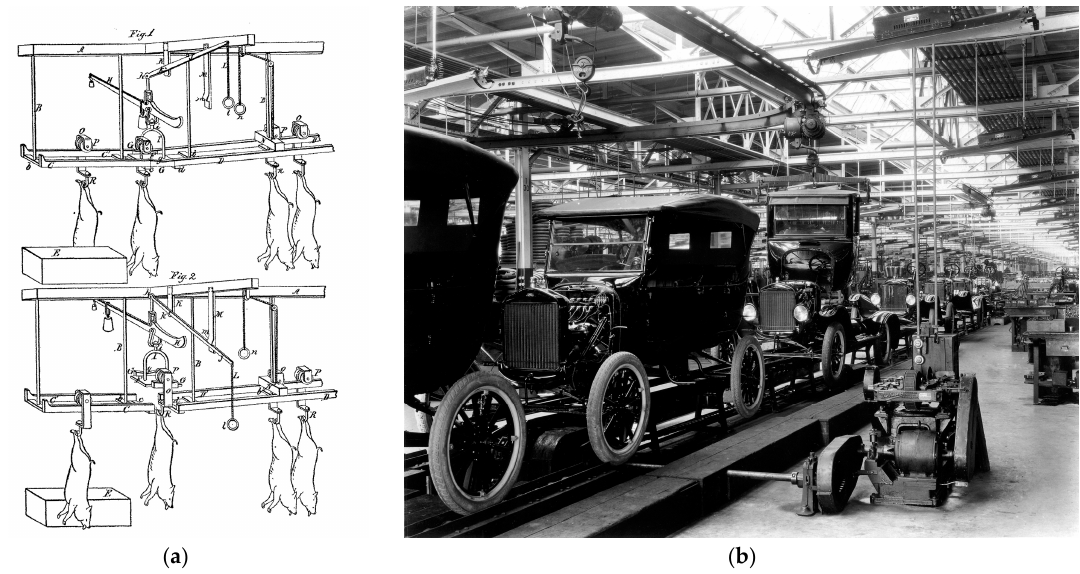
Figure 14. Automatic hog-weighing apparatus for use in packing houses, Cincinnati, 1869, and Assembly line production of Ford Model T, Ford Motor Company, Detroit, after 1913. First image from (Giedion 1948, p. 97); second image of unknown origin.